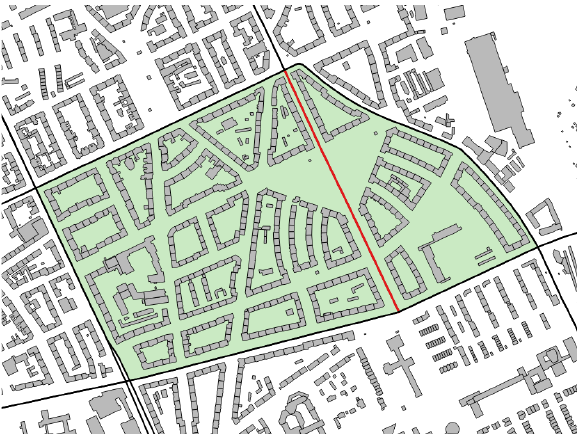
Figure 5. Number of buildings and inhabitants are aggregated on cells, which are formed by the street network (black). A street segment (red) receives from adjacent cells (green) their sum.